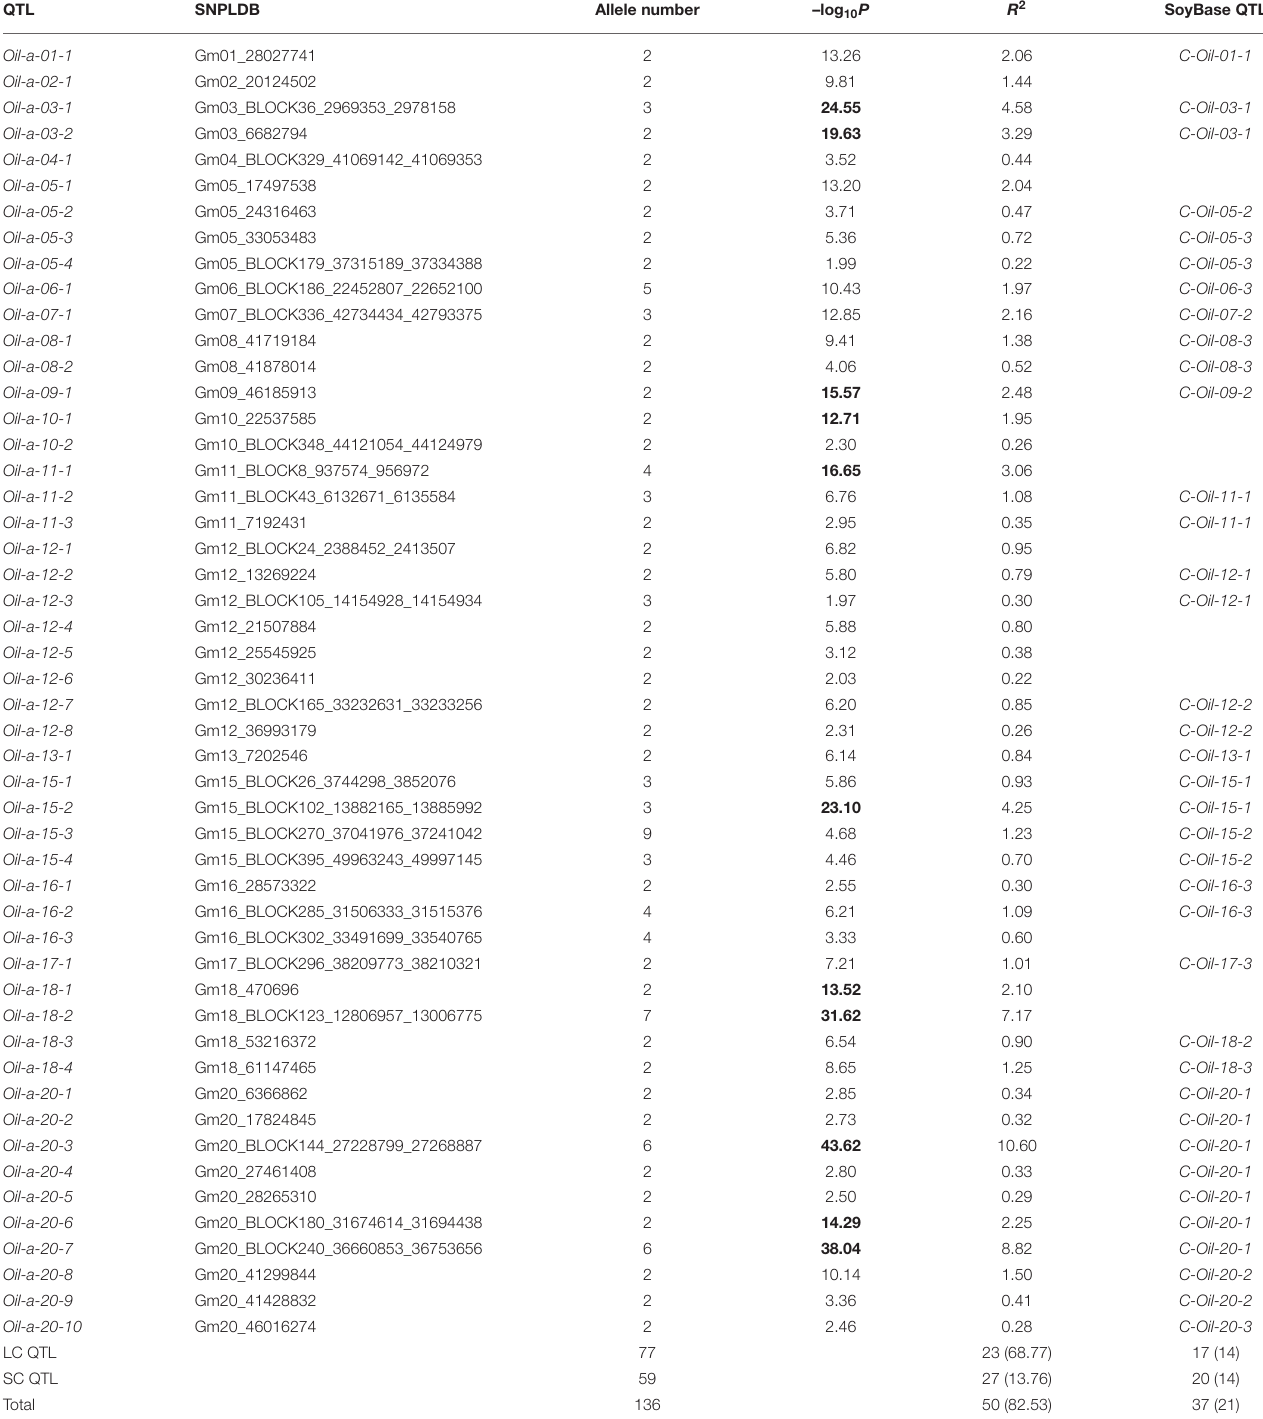
TABLE 3 | The detected SNPLDBs associated with seed oil content in CSLRP. QTL SNPLDB Allele number –log 10 P R 2 SoyBase